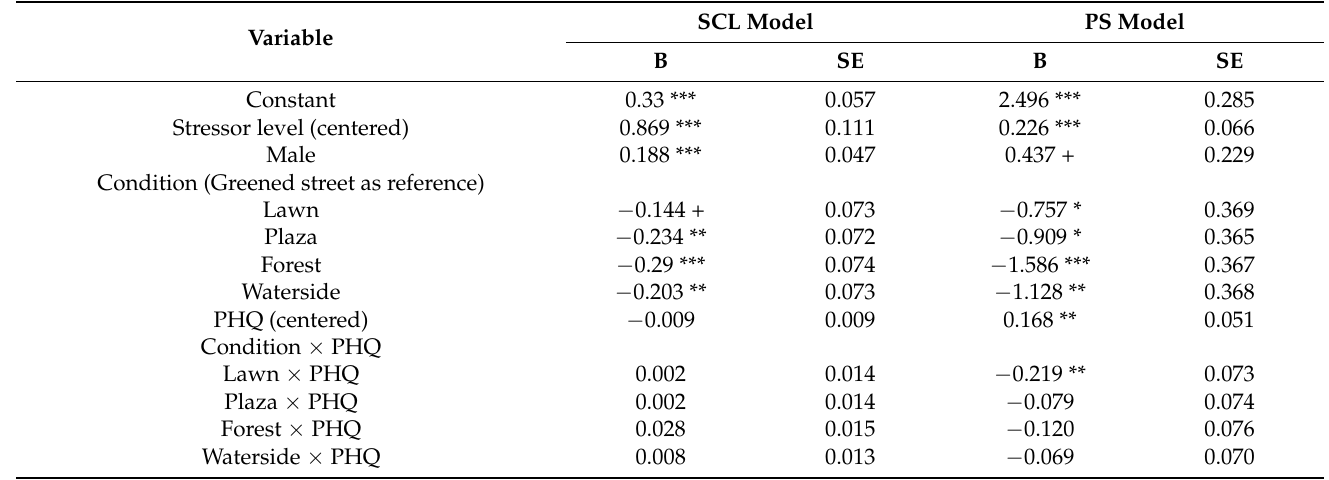
Table 4. Results of regression models testing the interaction between environmental condition and depressive symptoms (PHQ-9 sum score) on the outcome